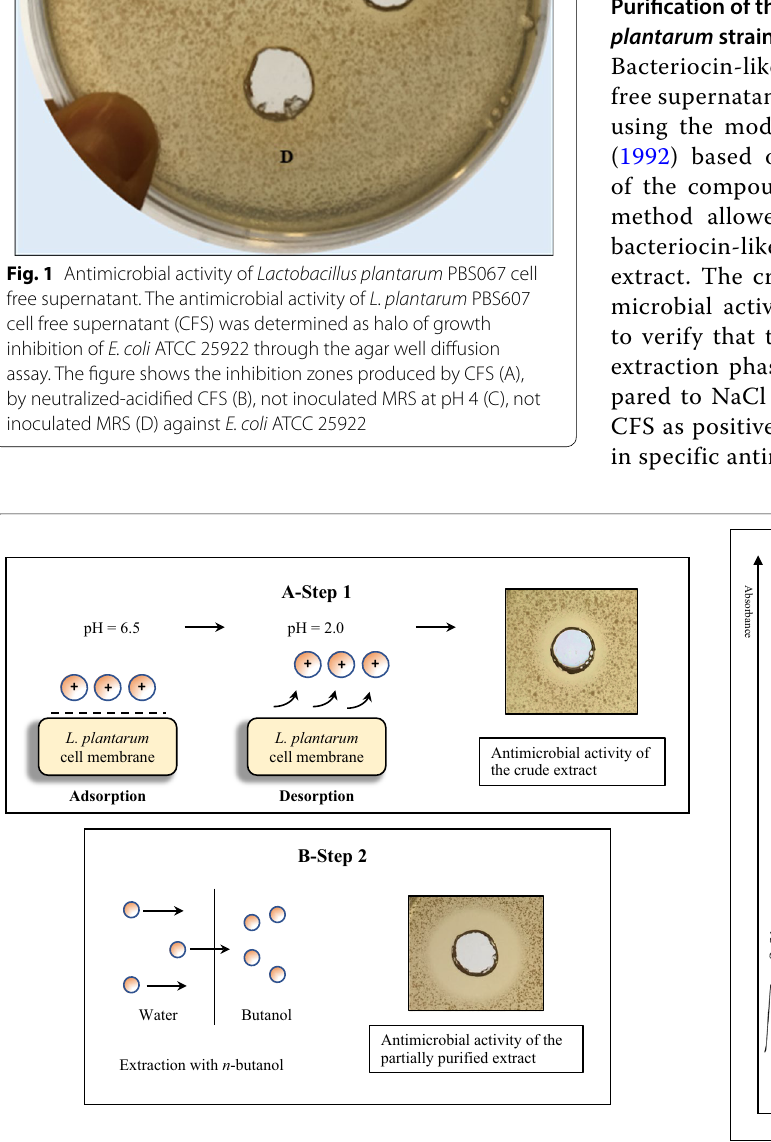
Fig. 2 Step-by-step purification and antimicrobial activity of the bacteriocin-like compound. The antimicrobial activity of the purified extract was verified through agar well diffusion assay. Step 1 of purification and inhibition halo produced by the crude extract obtained after adsorption/ desorption method (A), step 2 of purification and antimicrobial activity of the partial purified extract through an extraction with n -butyl alcohol (B), step 3 of purification and the growth inhibition of the eluted bacteriocin-like compound (C). All samples were tested against E. coli ATCC